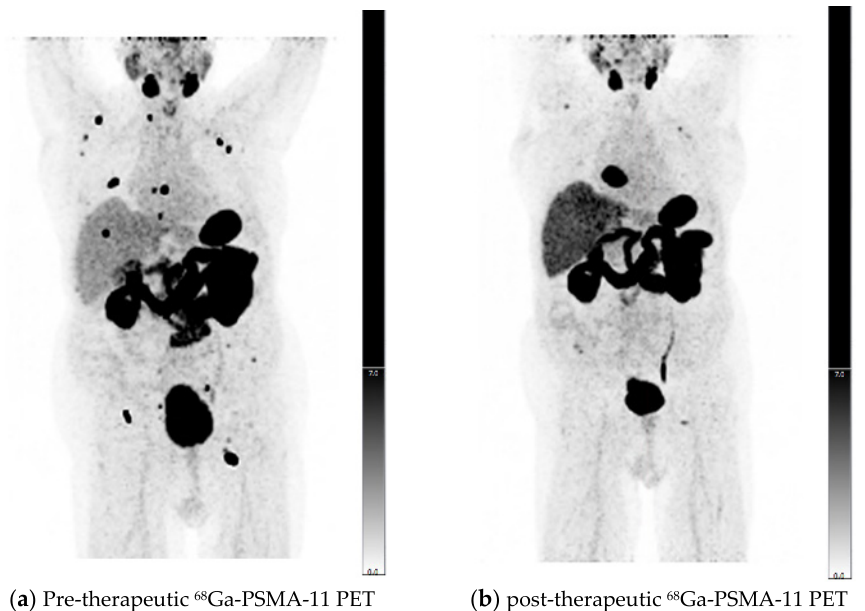
Figure 3. Pre- ( a ) and post-therapeutic PSMA-11 PET/CT ( b ) of an mCRPC patient with metastatic disease in bones and lymph nodes. Follow-up was performed after two cycles of 177 Lu-PSMA-617 RLT. Partial response was observed according to PERCIST criteria, and progressive disease ac- cording to RECIST 1.1 due to the significantly increased size of a cardiophrenic lymph node me-